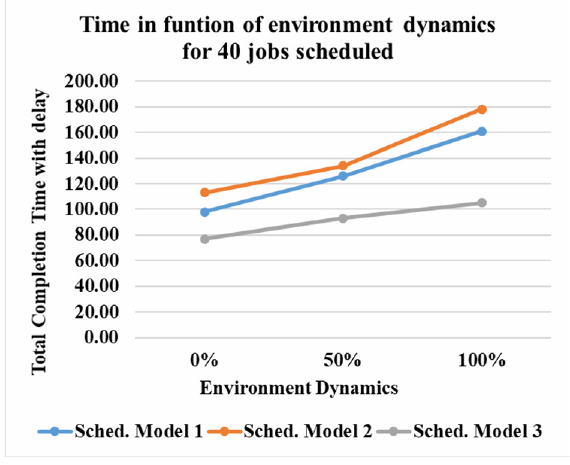
Figure 9. Effect of environment dynamics in total completion time over the 3 scheduling models for 40 jobs scheduled